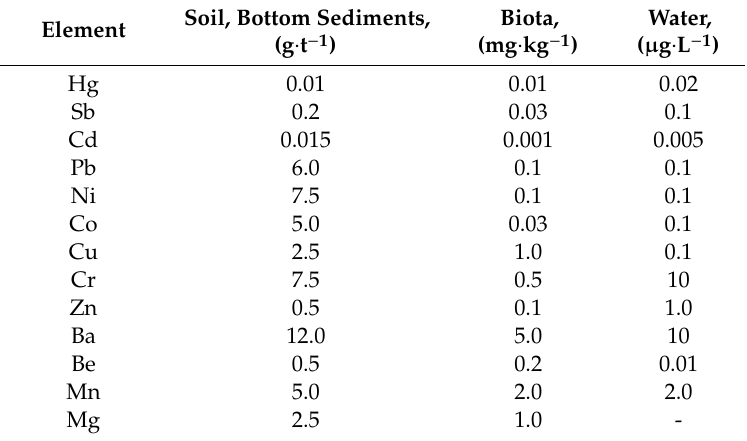
Table 1. Detection limits of trace elements by atomic absorption method.